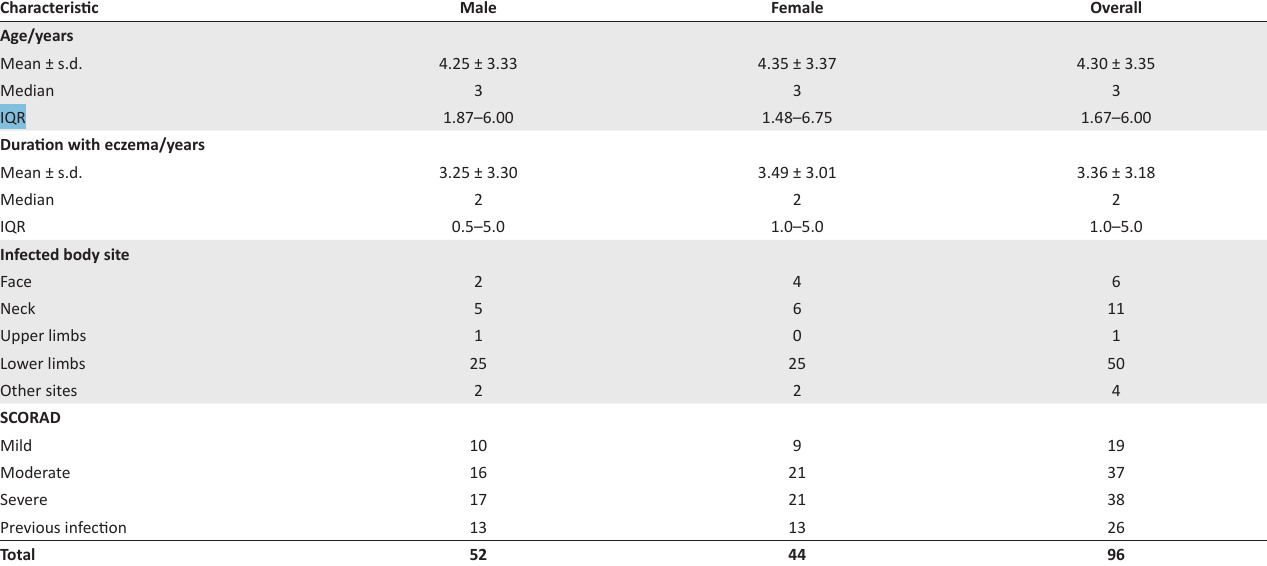
TABLE 1: Patient demographic characteristics.